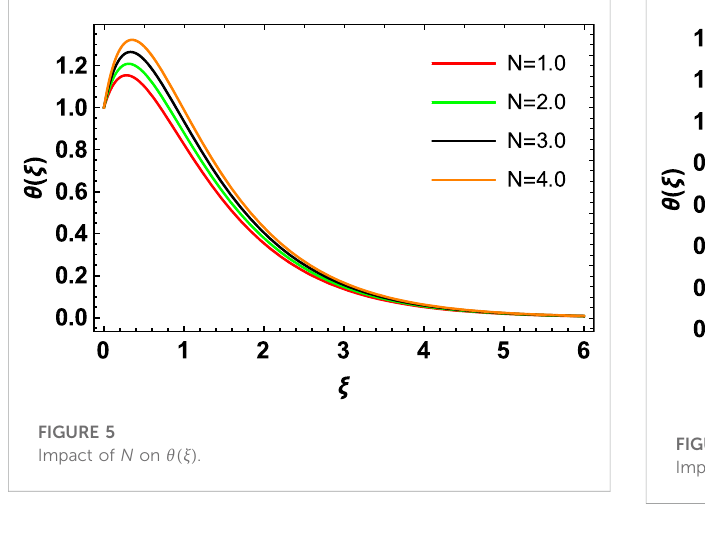
FIGURE 5 Impact of N on θ ( ξ ) .